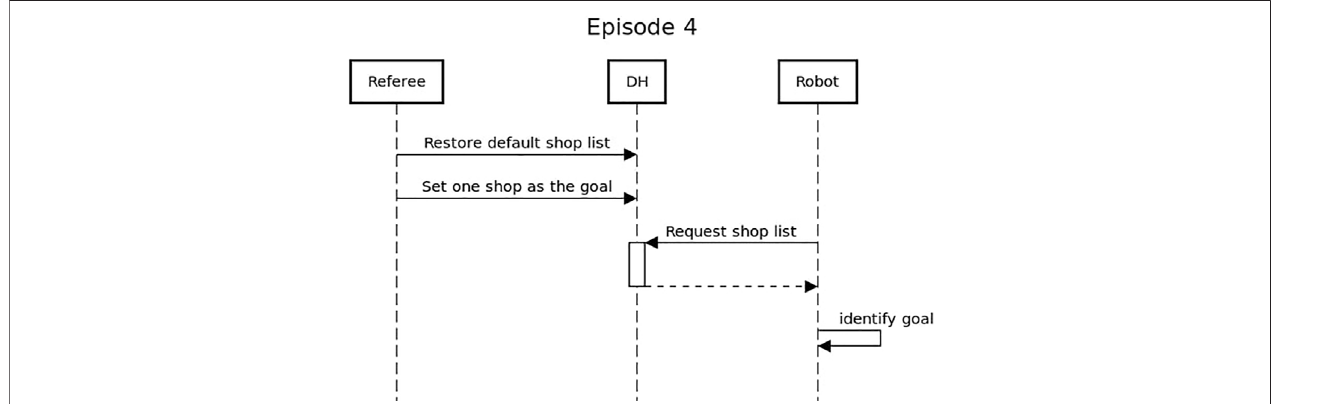
FIGURE 8 | Sequence diagram showing the interaction between the robot and the Data Hub for Episode 4